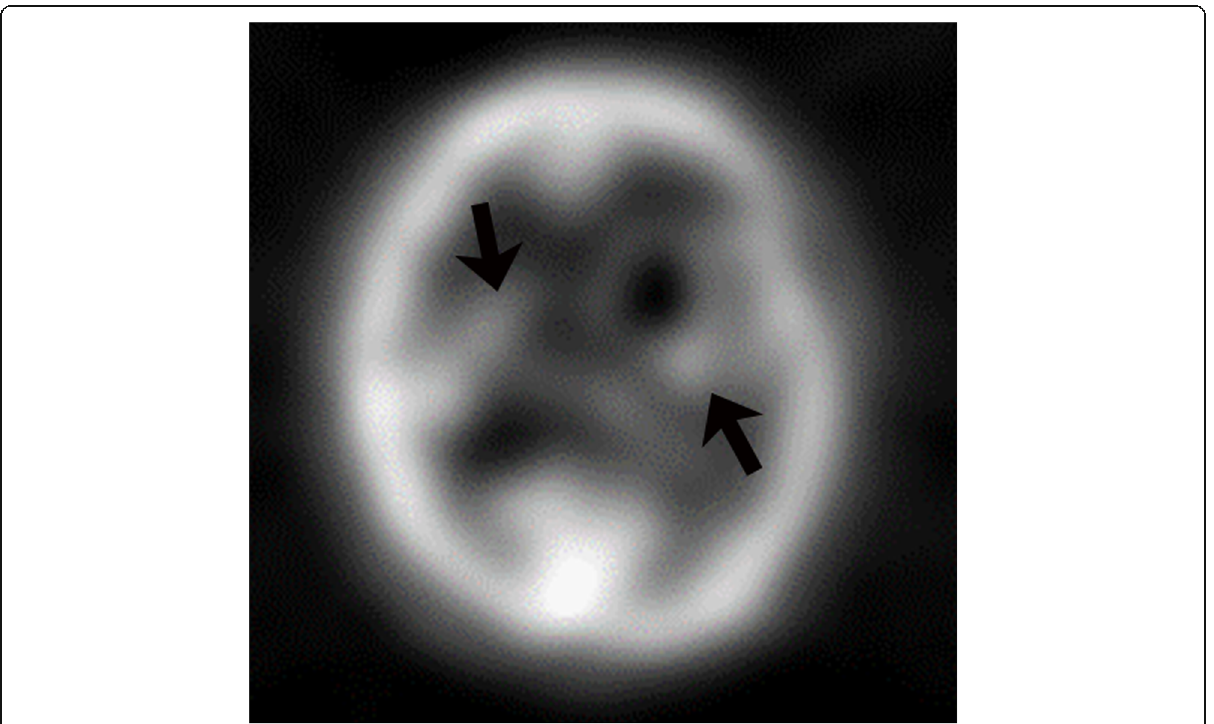
Fig. 6 Primary central nervous system post-transplant lymphoproliferative disorder. F-18 FDG PET exam demonstrates bilateral cerebral hypermetabolic lesions in the basal ganglia (arrows). The lesion on the left is larger but the lesion in the right basal ganglia had a higher SUVmax of 8.5 versus SUVmax of 7.2 in the left basal ganglia. Notice how hypermetabolic the cortex is and how this could obscure more peripheral lesions